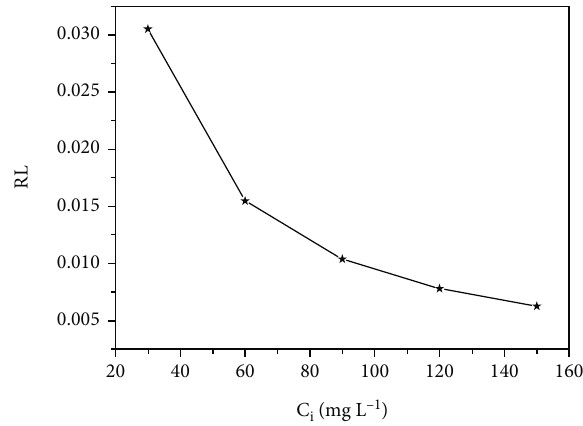
Figure 12: Plot of separation factor versus initial Pb 2+ metal ion concentration.